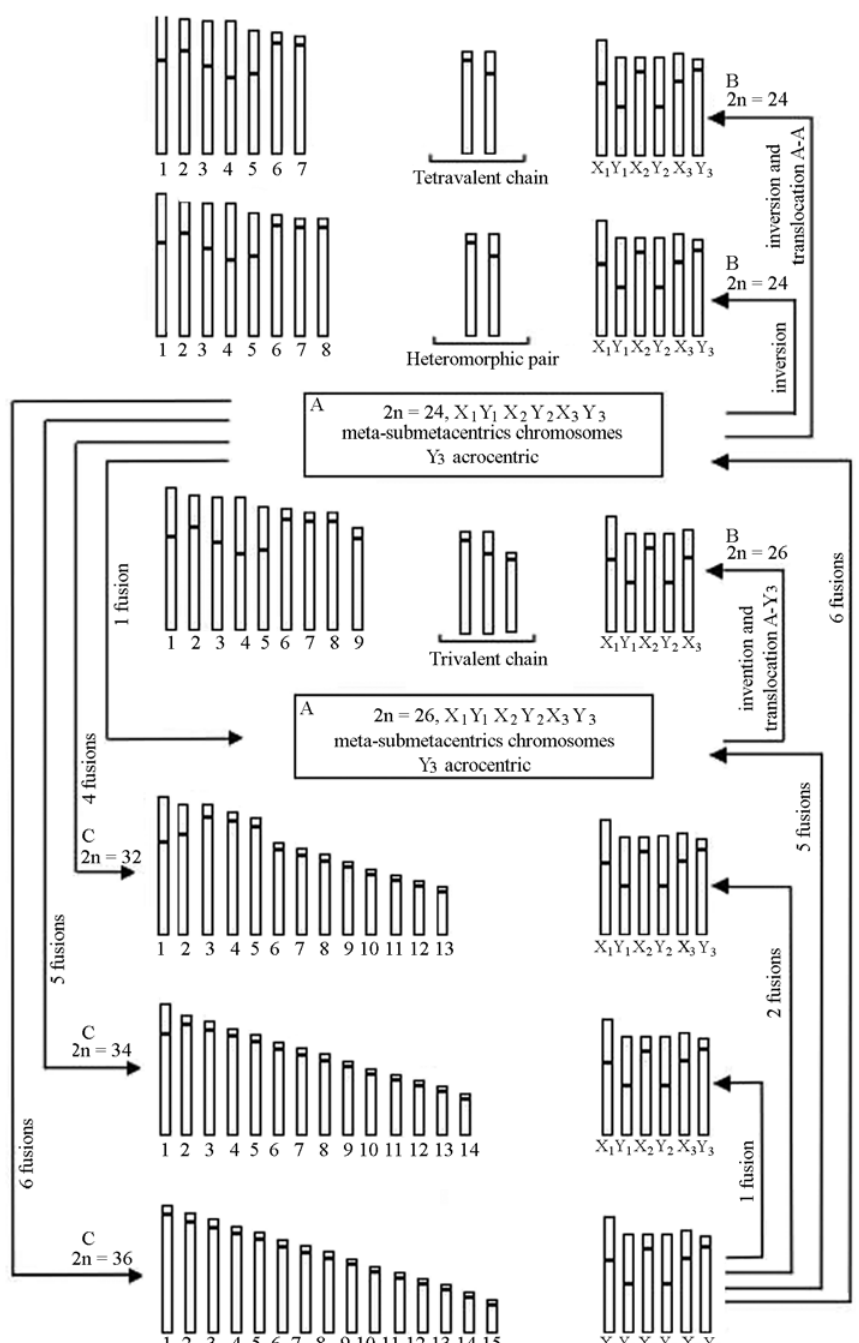
Figure 4 - Schematic representation of the different chromosome numbers observed in Euchroma gigantea and of the probable rearrangements that occurred during the chromosome evolution of this species. A - hypothetical karyotypes; B - karyotypes described by Mesa and Fontanetti (1984) and C - karyotypes observed in this